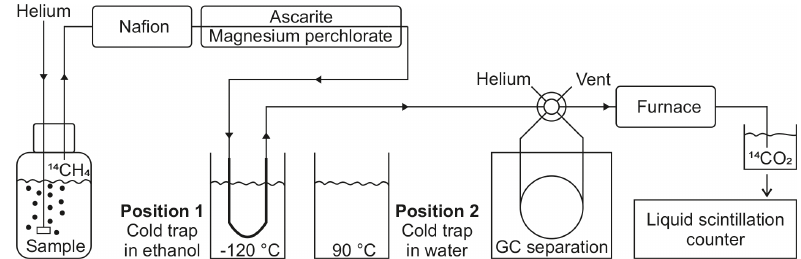
Figure 2. Schematic view of the methane stripping-oxidation line. Position 1 (displayed): the cold trap is placed in a − 120 ◦ C ethanol bath to retain the hydrocarbons. Position 2: the cold trap is transferred into a water bath at 90 ◦ C to release the hydrocarbons towards the gas chromatograph (GC). A detailed description is included in Sect. S2.